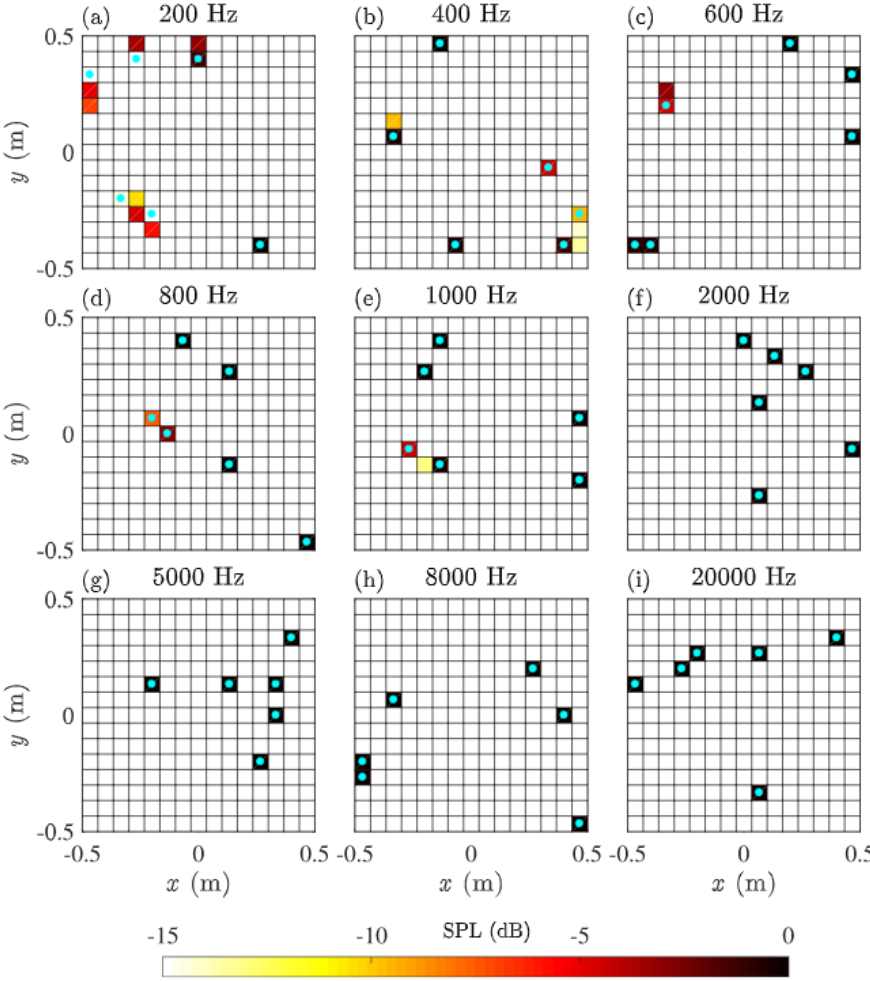
Figure 9. DenseNet performance at various source frequencies Xu et al. [119]. Reprinted with permission from